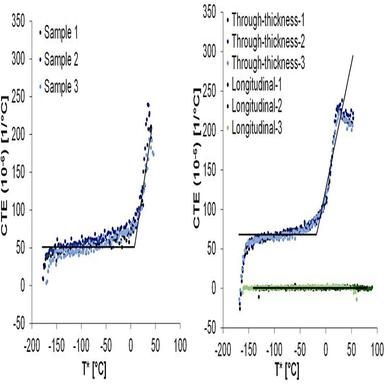
Through-thickness CTE results of neat resin (left) and laminate (right) for RS-36-1 along with its model (solid line). (For interpretation of the references to colour in this figure legend, the reader is referred to the web version of this article.)